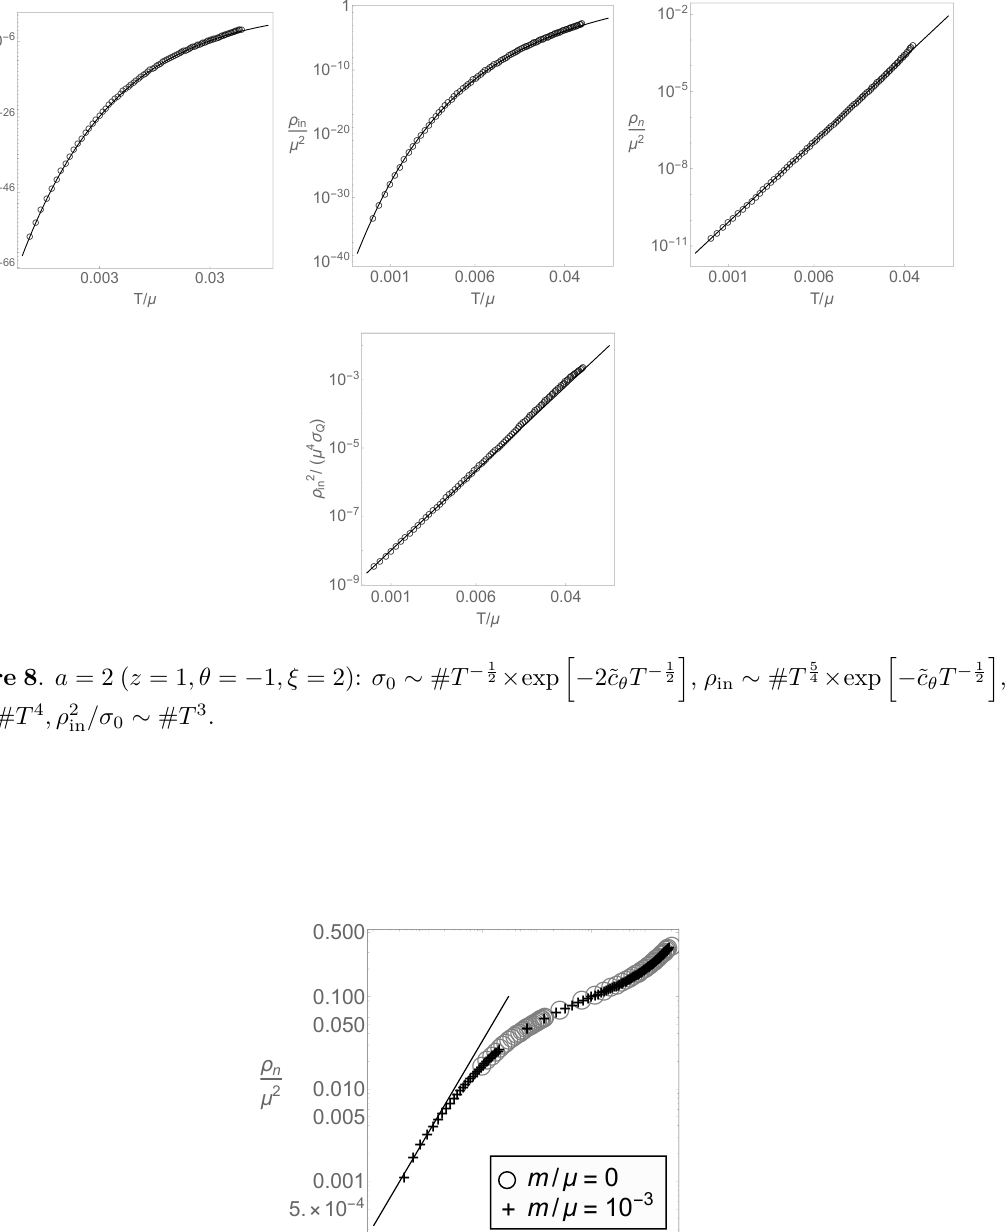
Figure 9 . Breaking translations allows for lower precision computing and we can find ρ n to lower temperature. Here, for z = 2 , we plot our result with m/µ = 0 in gray and for m/µ = 10 − 3 in black. The points exactly overlap and we confirm ρ n ∼ # T